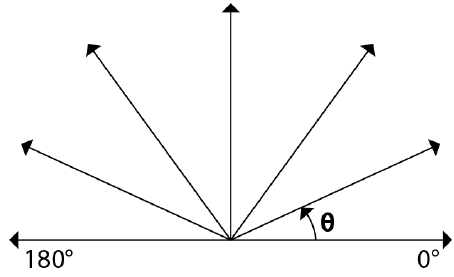
Figure 6. Expansion direction of smoke